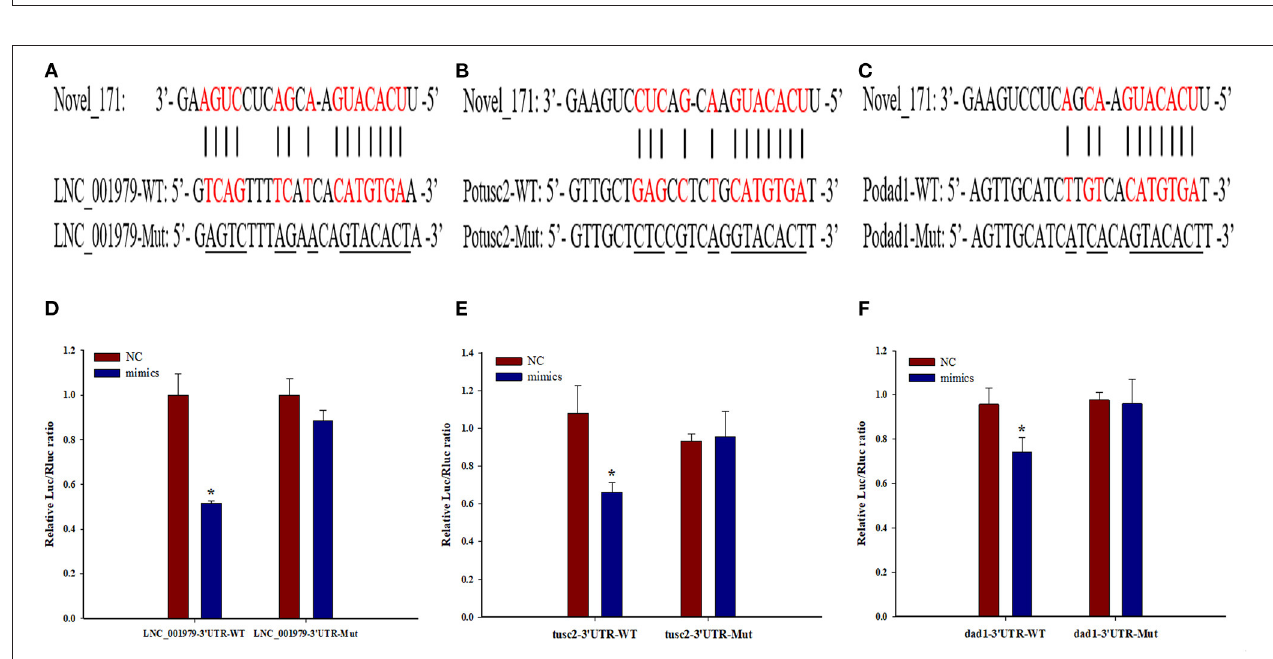
FIGURE 7 | The potential LNC_001979-novel_171-mRNA (Potusc2 and Podad1) ceRNA network. Sequence alignment of novel_171 and its binding sites in the LNC_001979 (A) , Potusc2 (B) , and Podad1 (C) . HEK293 cells were transfected with wild-type or mutant LNC_001979 (D) , Potusc2 (E) , and Podad1 (F) , together with novel_171 mimics, or NC. The asterisks (*) indicate significant differences ( P < 0.05) between the NC and mimics group.